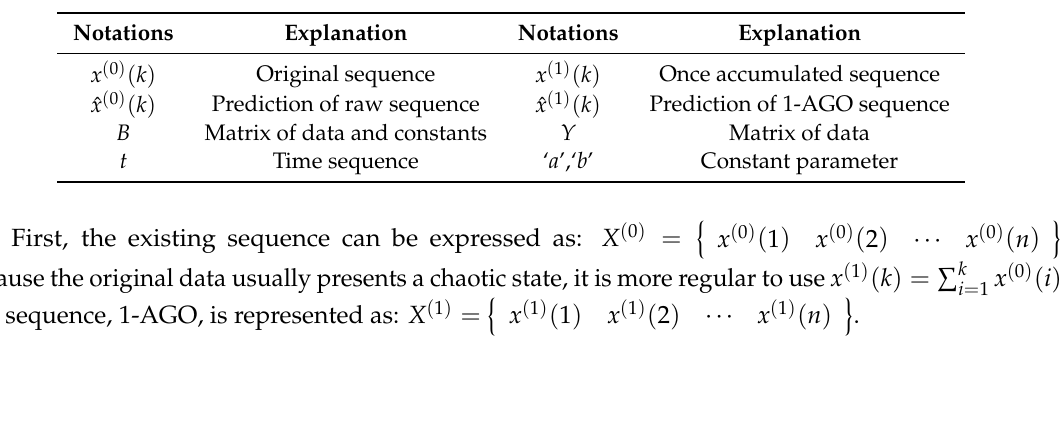
Table 1. Explanation of the symbols in the following